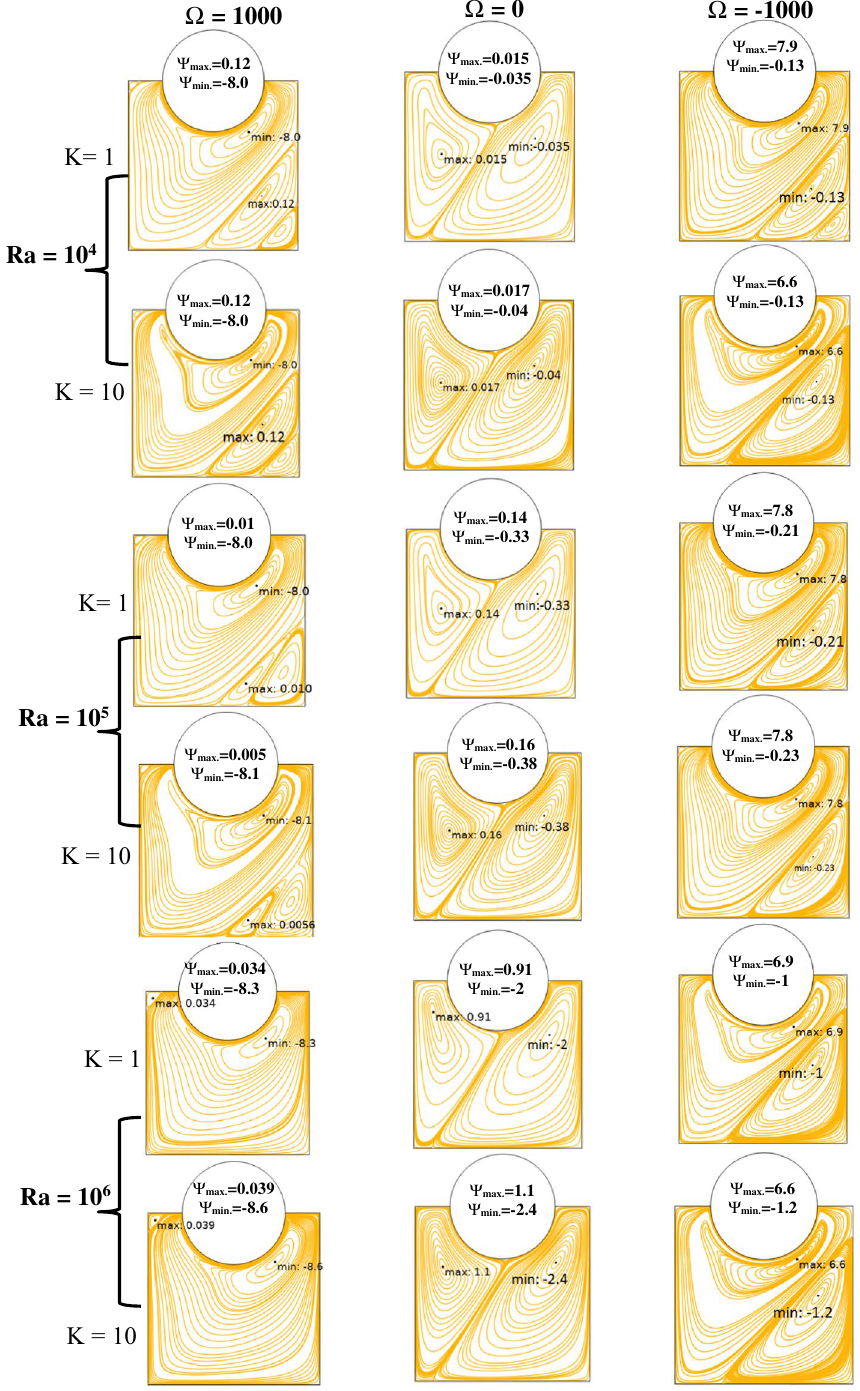
Figure 5. Streamlines for different Rayleigh numbers, dimensionless rotating angular velocities, and thermal conductivity ratios at Ha = 60, λ = 0.52, and